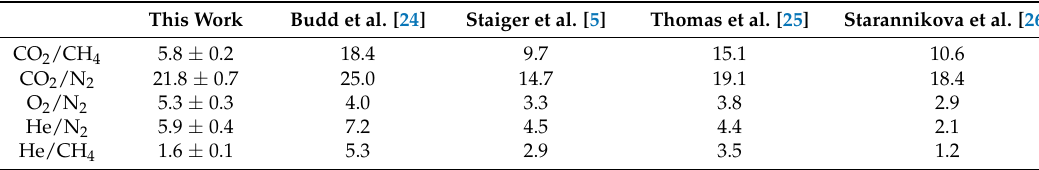
Table 3. Selectivity of PIM-1 membrane at 35 ◦